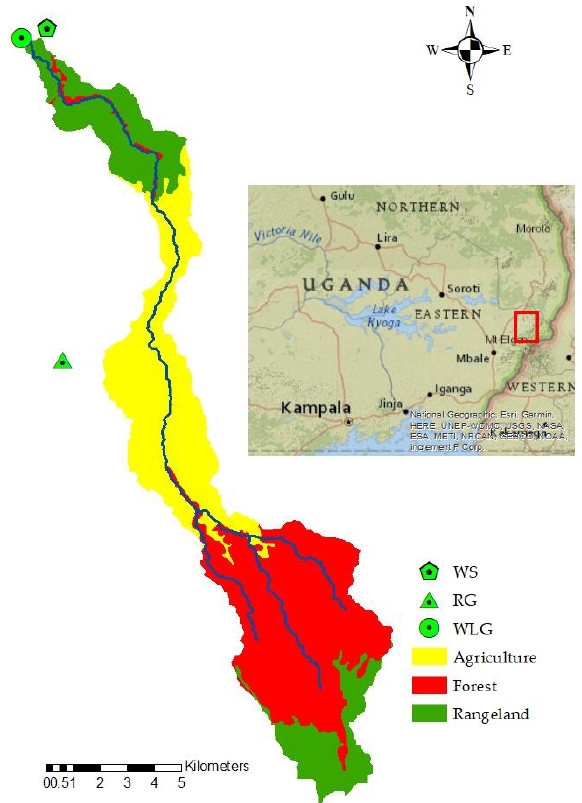
Figure 1. Instrumentation and land use in Atari River catchment. WS (weather station); RG (rain gauge); WLG (water level gauge).